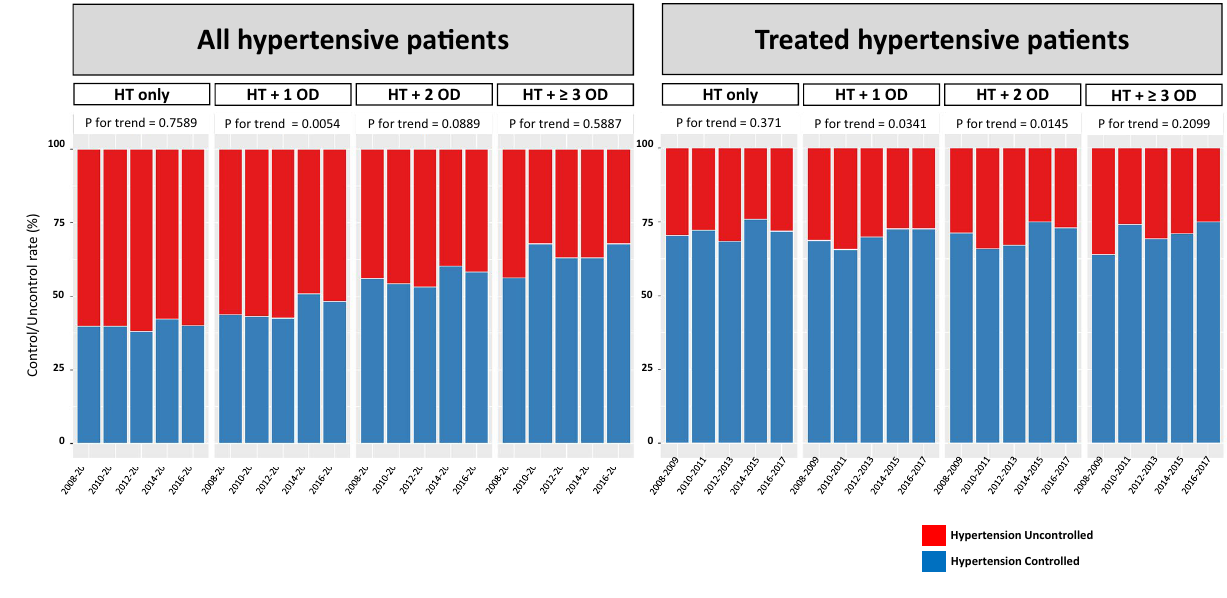
Figure 4. Hypertension control rate according to number of accompanying chronic medical conditions. The hypertension control rate is higher in patients with other medical condition than hypertension only patients. Number of co-morbidities represents the sum of diabetes mellitus, hypercholesterolemia, obesity, and impaired GFR (range; 0–4). HT hypertension, OD other disease. Trend analysis was performed by regression analysis and age-adjusted P values are presented.